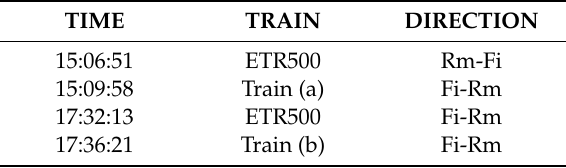
Table 1. Timetable of the four passages considered in the analysis.